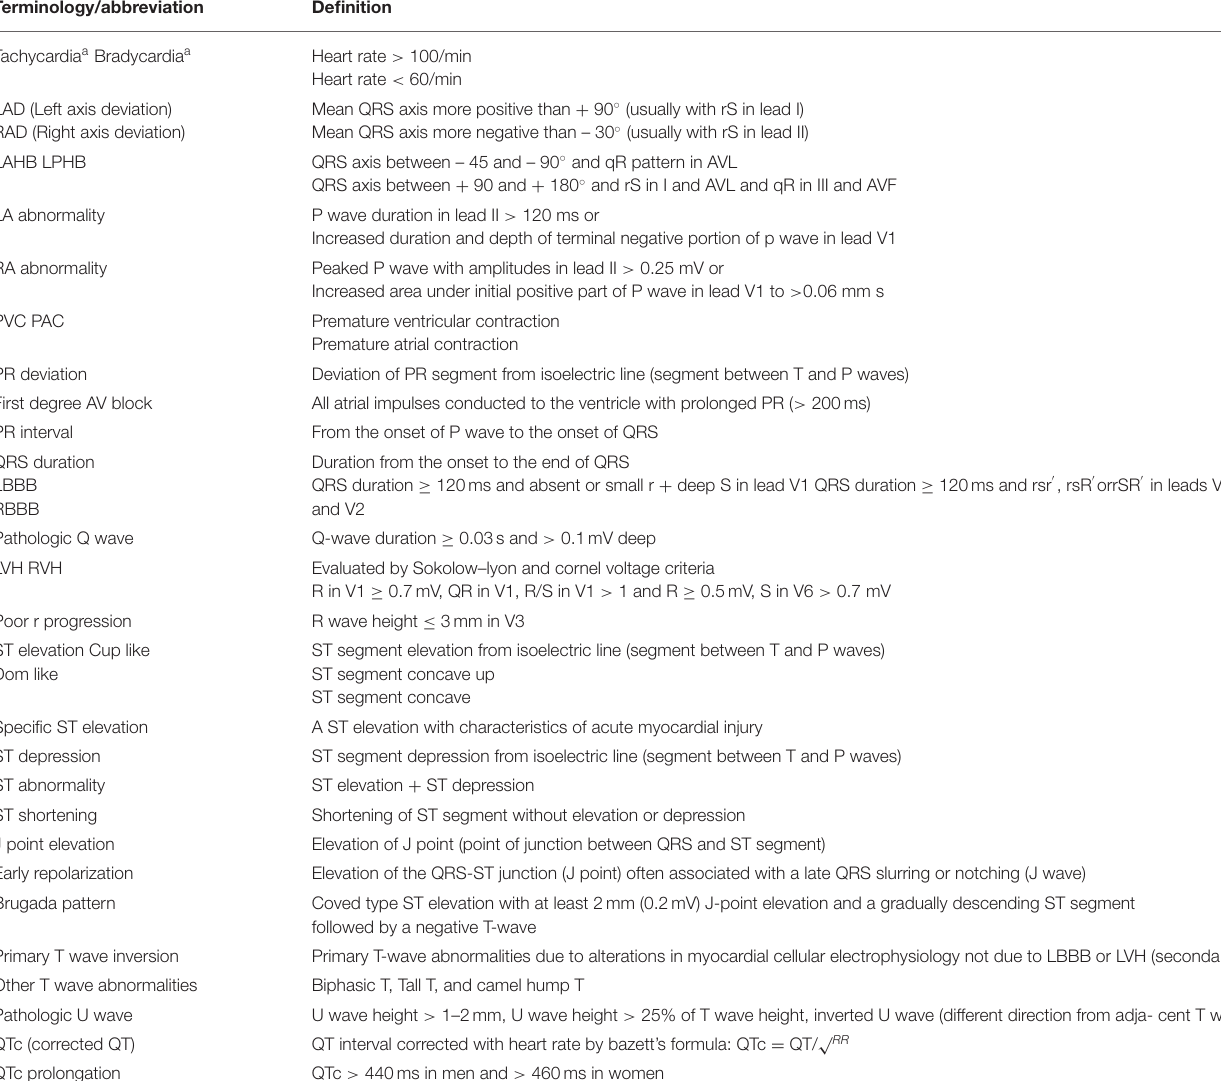
TABLE 1 | Definitions used for determination of abnormal